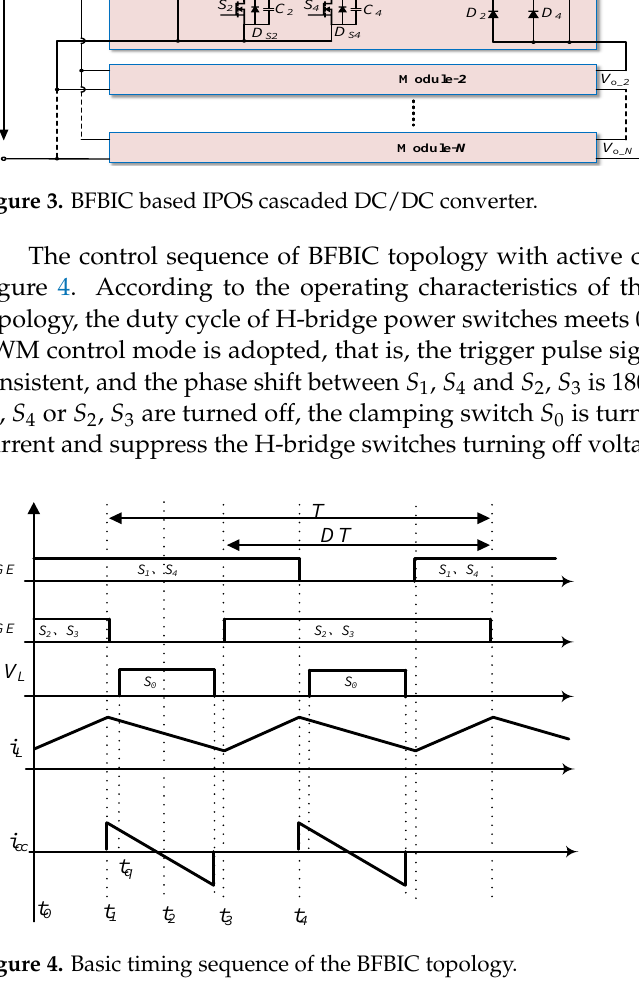
Figure 4. Basic timing sequence of the BFBIC topology.